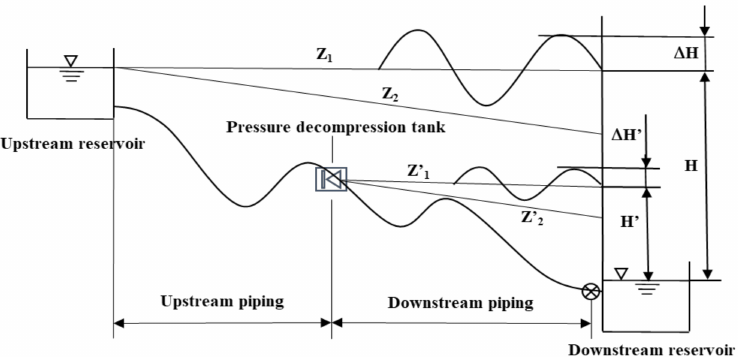
Figure 2. Schematic diagram of working principle of the